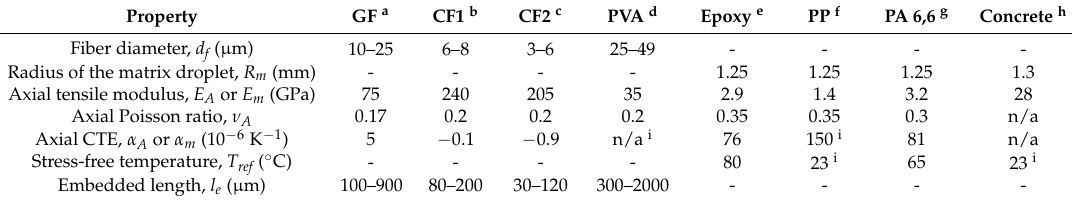
Table 1. Fiber and matrix properties and specimen